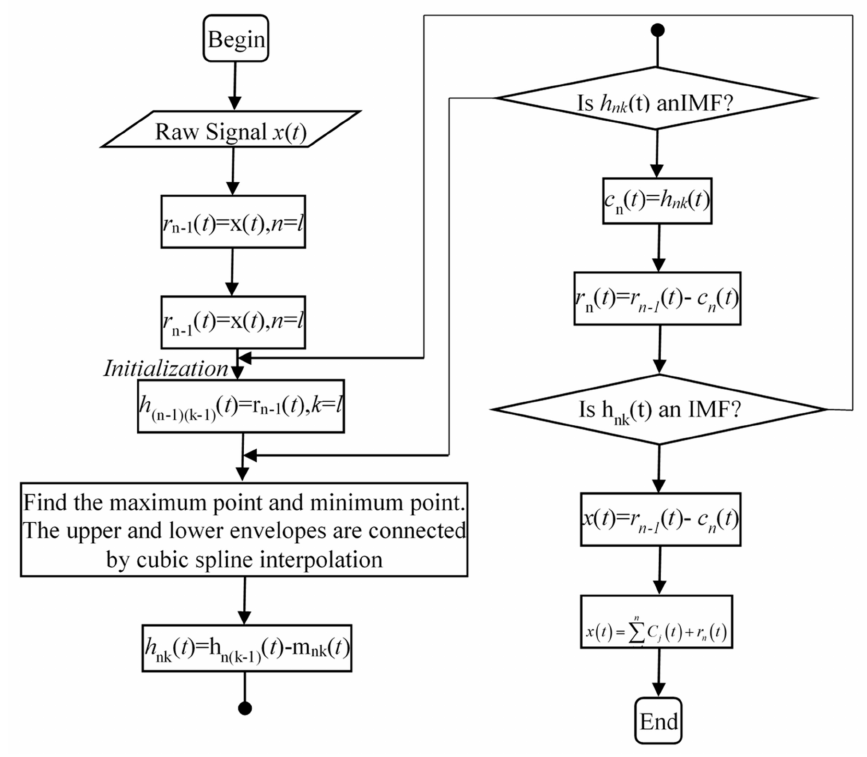
Figure 1. The flowchart for Empirical Mode Decomposition